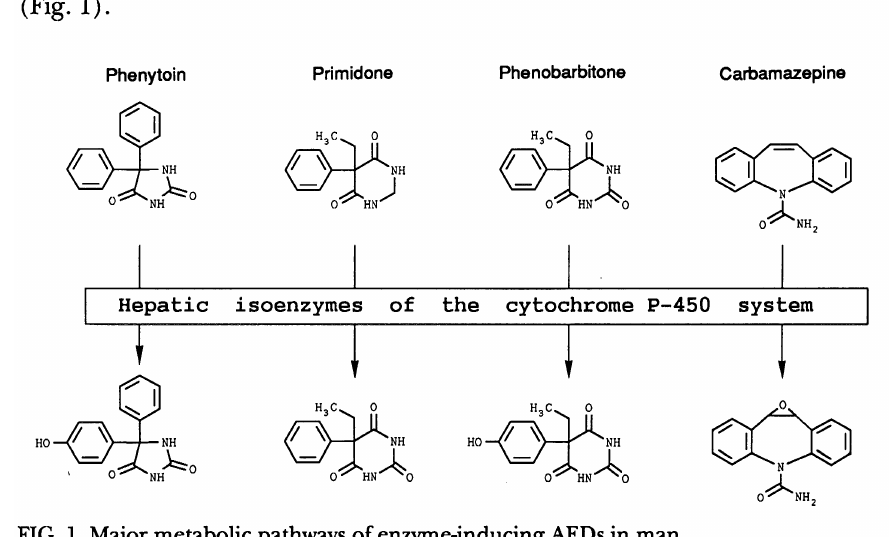
FIG. 1. Major metabolic pathways of enzyme-inducing AEDs in